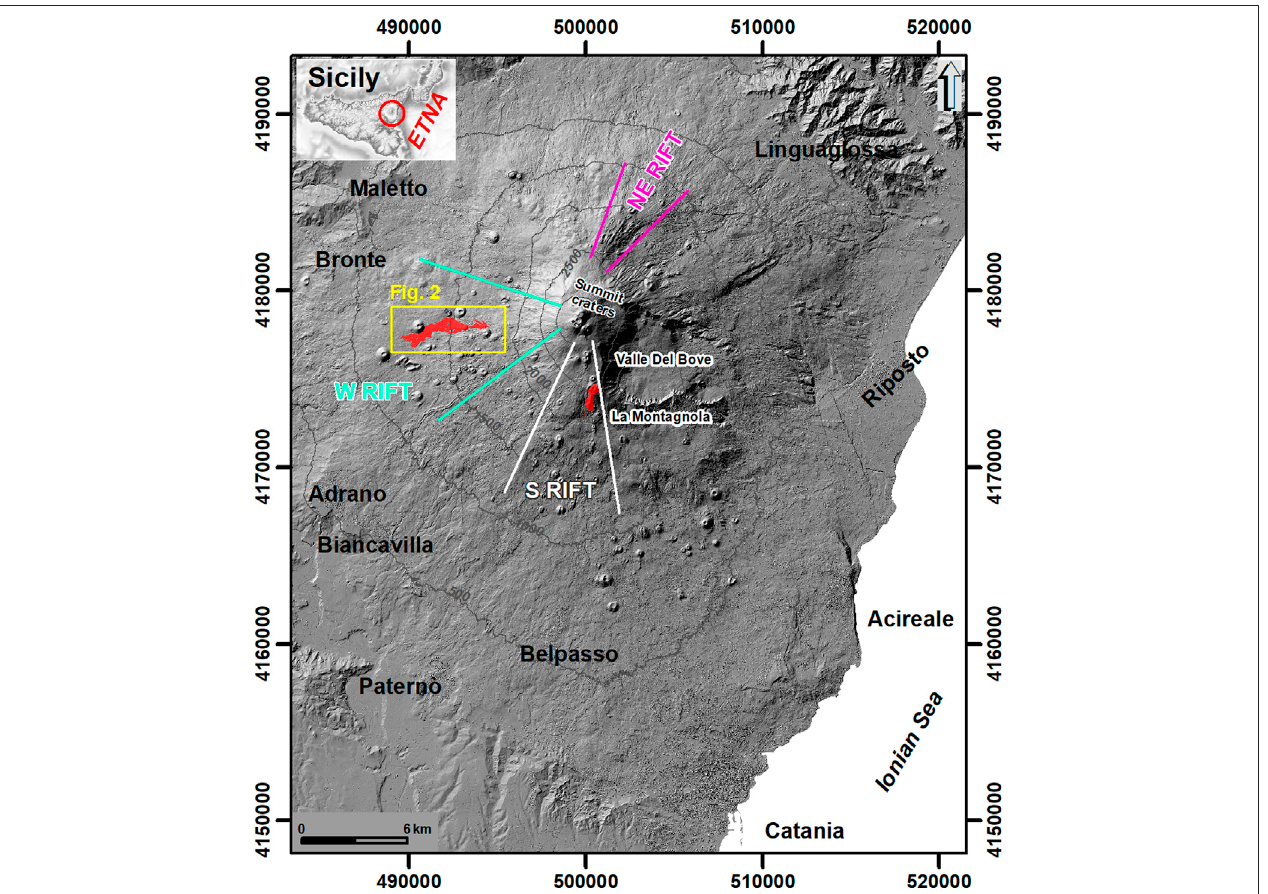
FIGURE 1 | Shaded relief of Etna re-sampled to 10 m resolution (Gwinner et al., 2006); studied area is localized in the west fl ank of the volcano (yellow rectangle zoomed-in Figure 2 ); in the south fl ank, the lava fl ow of La Montagnola is shown in red. Colored lines delimit the S, W, and NE rifts. Inset represents the shaded relief of Sicily obtained from the TINITALY DEM re-sampled to 100 m resolution available at: http://tinitaly.pi.ingv.it (Tarquini et al., 2007), red circle indicates Etna position.